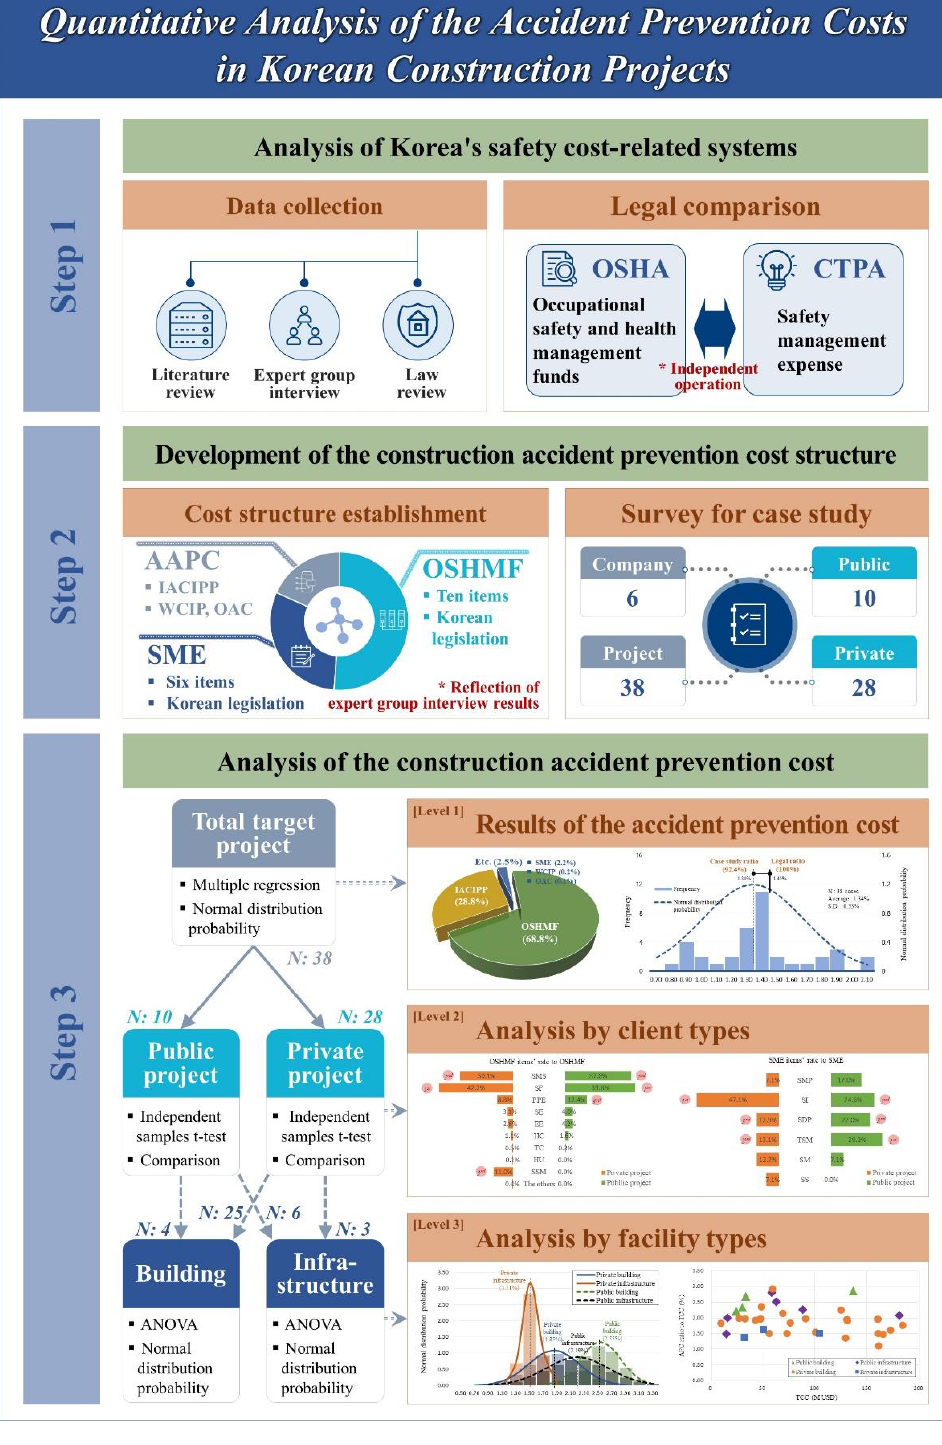
Figure 1. Research framework adopted in this